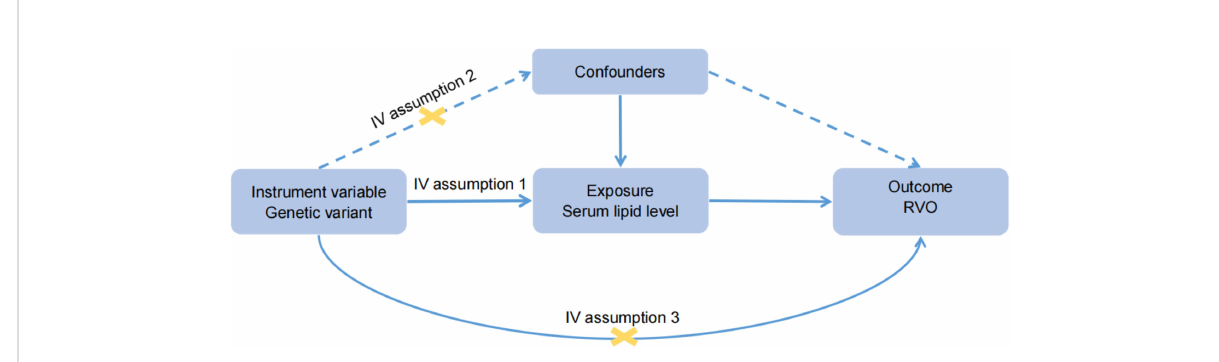
FIGURE 1 Basic assumptions of Mendelian randomization. Assumption 1: The genetic variants were strongly and causally related to exposure; Assumption 2: the genetic variants were not associated with any potential confounders; Assumption 3: each genetic variant and the outcome did not have common